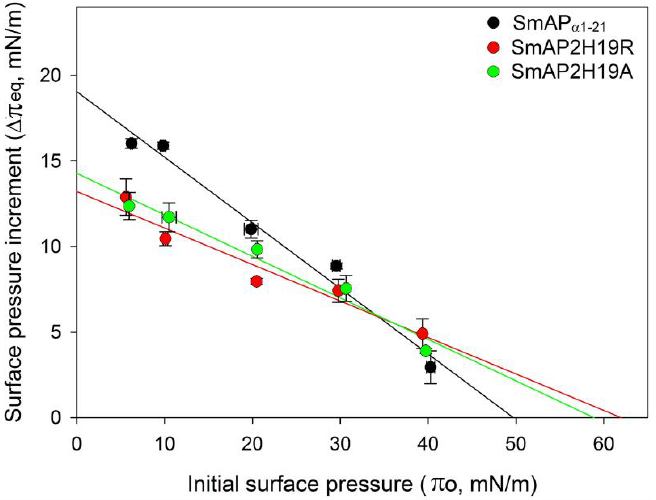
Figure 4. Increment in surface pressure at equilibrium ( ∆ π eq) obtained after injection of peptides (20 µ M) beneath the POPC–ergosterol monolayers at different initial surface pressures ( π o ) of lipid films. Maximum insertion pressure (MIP parameter) for each peptide was obtained from these plots by extrapolating linear regression curves to ∆ π eq = 0.